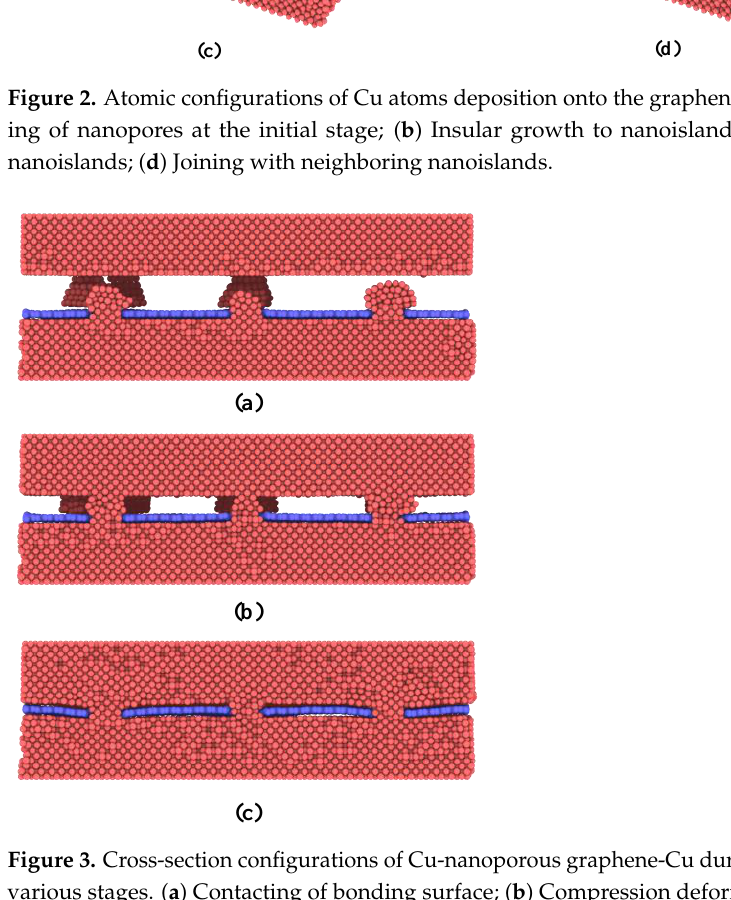
Figure 2. Atomic configurations of Cu atoms deposition onto the graphene at various stages. ( a ) Filling of nanopores at the initial stage; ( b ) Insular growth to nanoislands; ( c ) Further growing of nanoislands; ( d ) Joining with neighboring nanoislands.